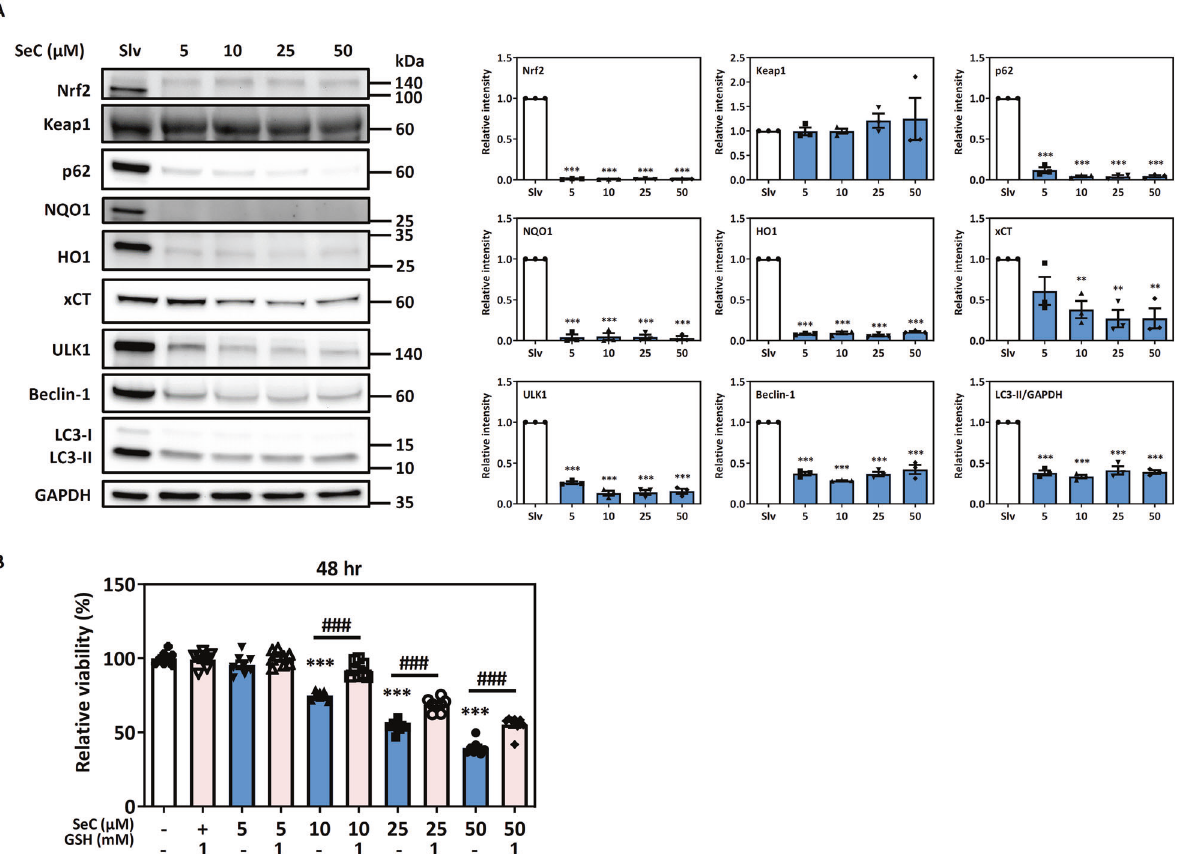
Fig. 6 SeC inhibits Nrf2 and autophagy pathway proteins in C 2 BBe 1 cells after 48 h of treatment. A Nrf2, Keap1, p62, NQO1, HO1, xCT, ULK1, Beclin-1, and LC3II levels in C 2 BBe 1 cells after SeC treatment for 48 h (* p < 0.05, * p < 0.01, *** p < 0.001, compared with solvent control, signi fi cance was determined by an unpaired t test). The values were presented as average ± SD from three independent repeats. B Relative viability of SeC-treated C 2 BBe 1 cells with or without GSH pretreatment for 48 h. The values were presented as average ± SD from eight independent repeats. (* p < 0.05, ** p < 0.01, *** p < 0.001, compared with solvent control; ## p < 0.01, ### p < 0.001, compared with SeC alone, signi fi cance was determined by one-way